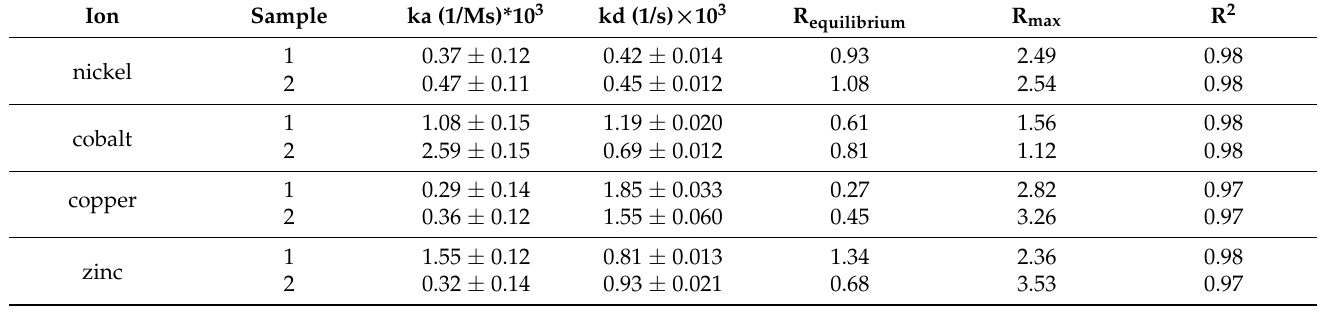
Table 2. Parameters determined for different divalent cations. The corresponding sensograms are shown in Figure 3. Values are shown for two independent measurements.